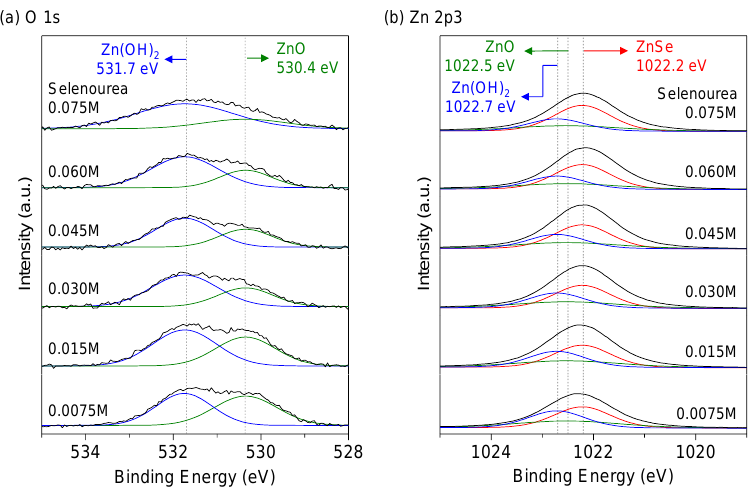
Figure 10. After sputtering for 120 s, ( a ) oxygen 1s and ( b ) zinc 2p3 binding-energy spectra of Zn(Se,OH) films, deposited with ammonia concentration of 0.03 M and selenourea concentrations in the range of 0.0075 to 0.075 M.